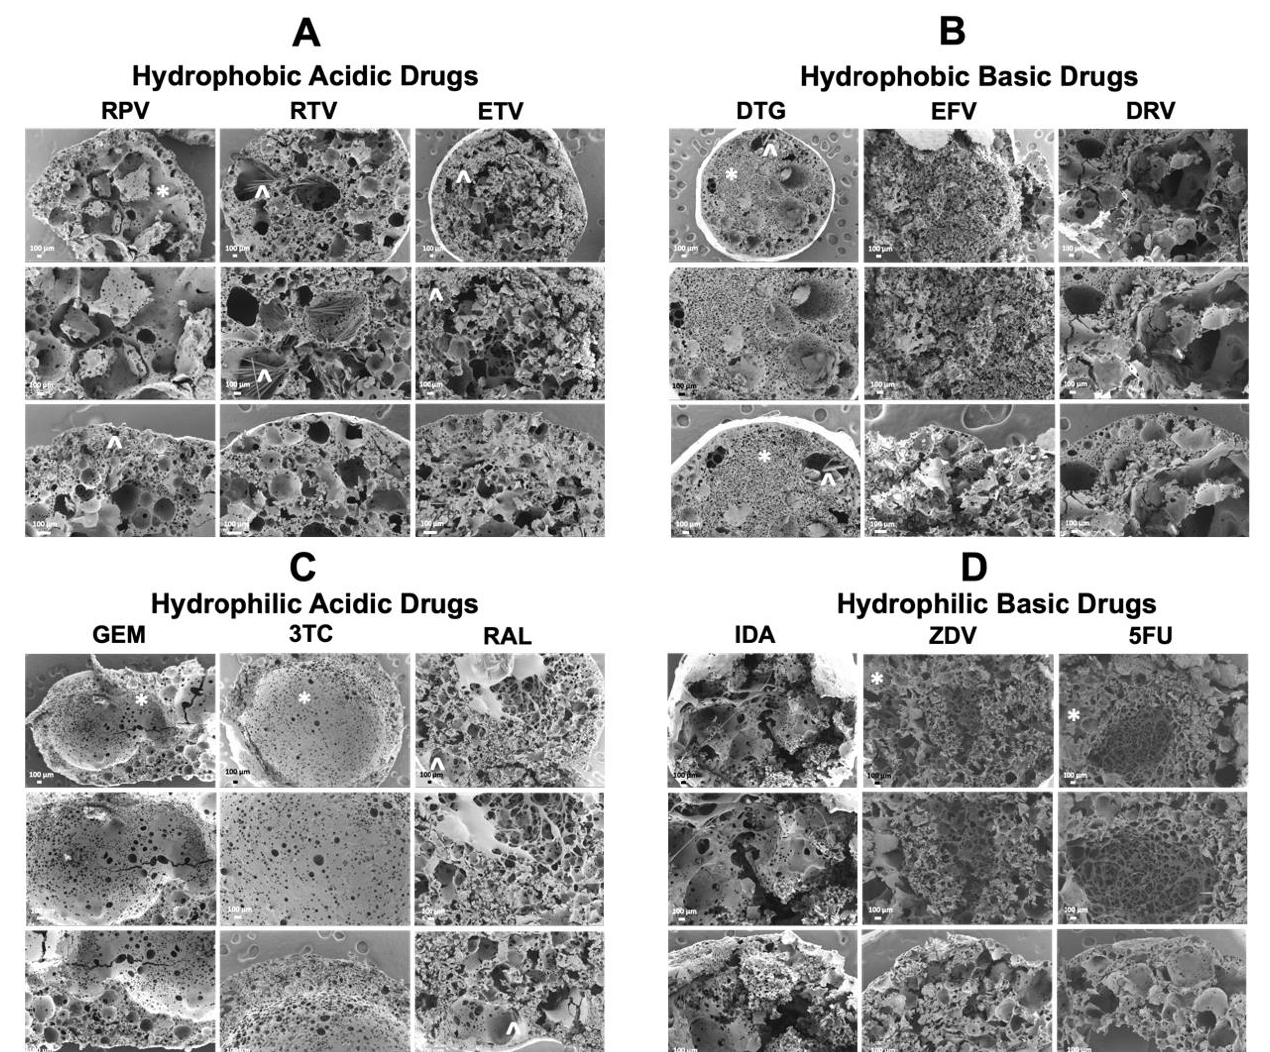
Figure 7. SEM cross-section images of drug-loaded ISFIs. ( A ) Implants with hydrophobic–acidic drugs (RPV, RTV, and ETV). ( B ) Implants with hydrophobic–basic drugs (DTG, EFV, and DRV). ( C ) Implants with hydrophilic–acidic drugs (GEM, 3TC, and RAL). ( D ) Implants with hydrophilic–basic drugs (IDA, ZDV, and 5FU). Each column within A, B, C, and D matrix represents increasing magnification (60 × , 100 × , and 200 × ). Scale bar = 100 µ m. (*) denotes polymer and (ˆ) denotes